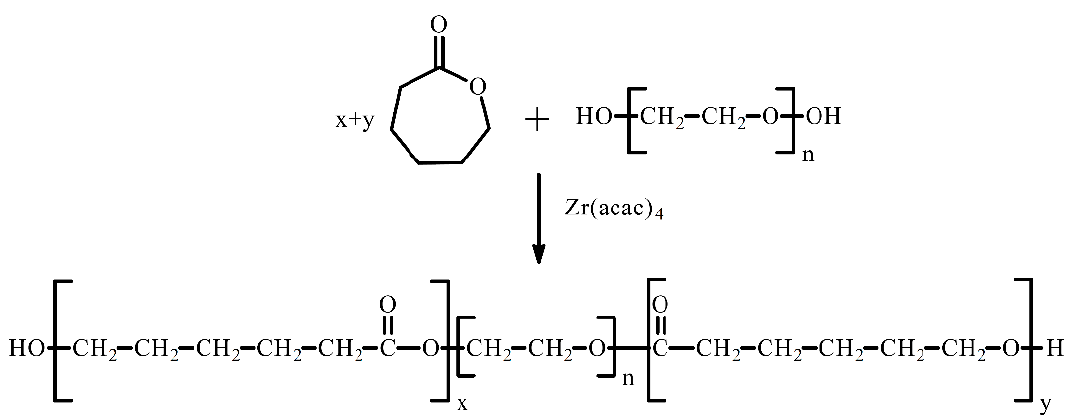
Table 1. PCEC triblock copolymers synthesis and characterization.